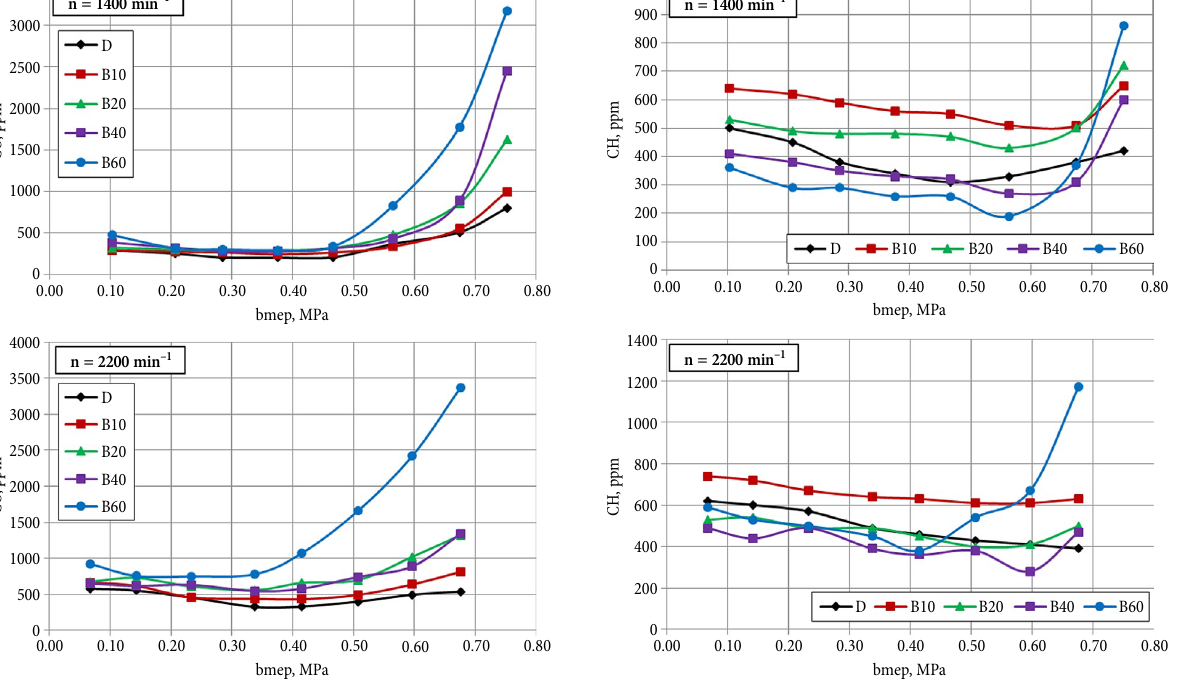
as function of engine load ( bmep